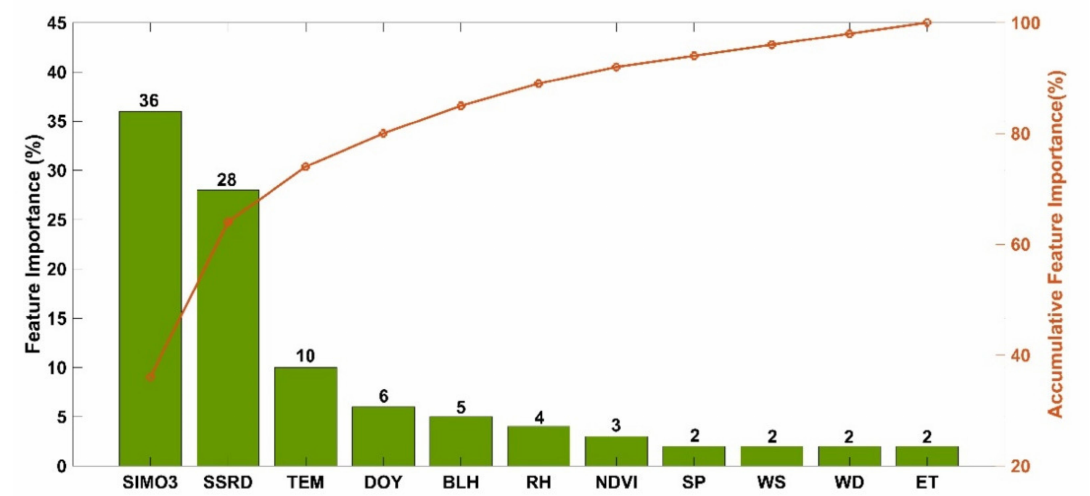
Figure 2. FIs and accumulative feature importance of the independent variables of the WRFC-XGB model for the O 3 estimation.